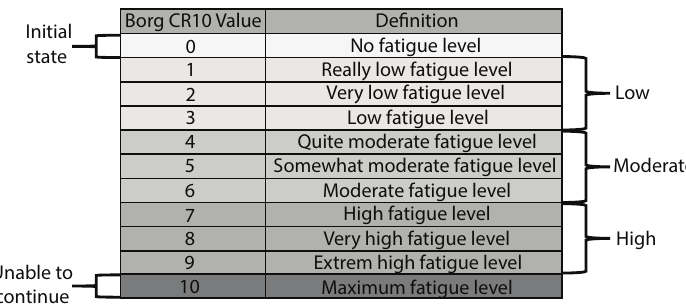
Figure 1. Borg CR10 definition